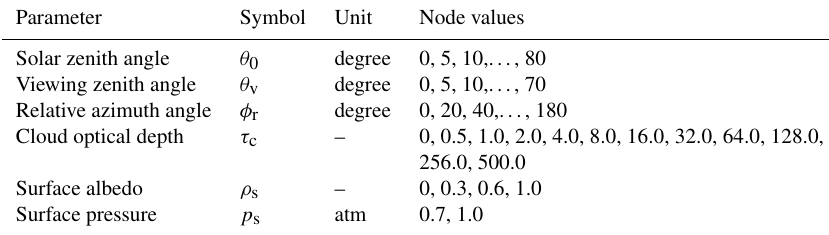
Table 1. Node points of the cloud optical depth look-up table.